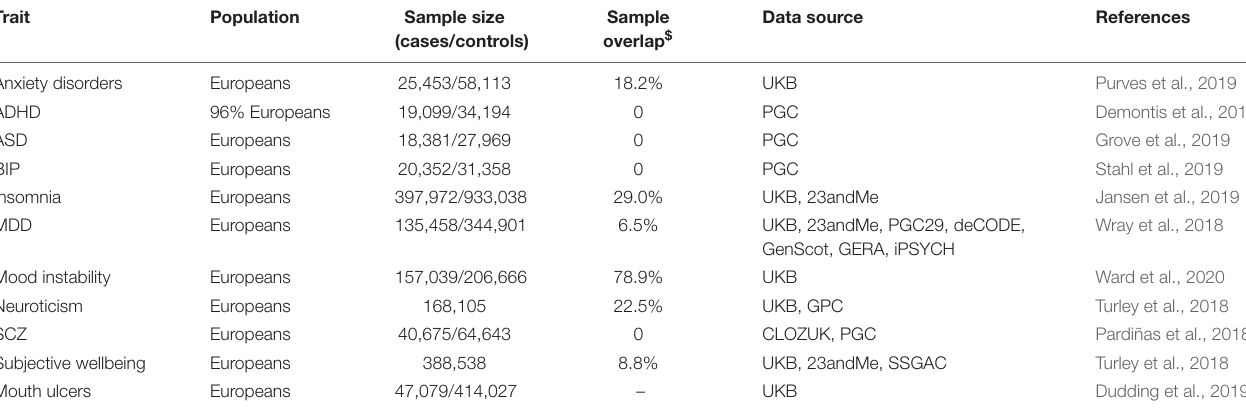
TABLE 1 | Description of GWAS consortiums used for each trait. Trait Population Sample size